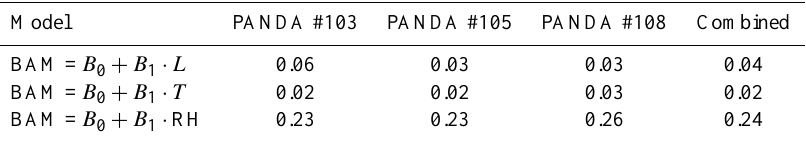
Table 1a. Adjusted R 2 for linear regressions of BAM (PM 2 . 5 µgm − 3 ) on covariates. L =light (lux), T =temperature ( ◦ C), RH=relative humidity (%). Each PANDA has its own RH/ T sensor. R 2 statistics were calculated on a per-PANDA basis (columns 2–4) as well as for a “combined” model (column 5). The “combined” R 2 values are not the means of R 2 in columns 2–4, but were obtained by fitting the specified model form to the means of the regressands ( L , RH, or T ) averaged across all 3 PANDAs at each point in time.